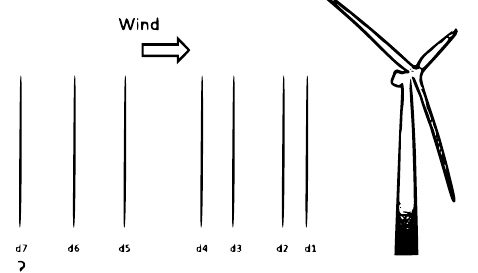
Figure 4. Plane of measurements upstream the wind turbine in the LiDAR experimental campaign. Data are available in the six planes that are closer to the wind turbine, while the data on the seventh plane are to be predicted.